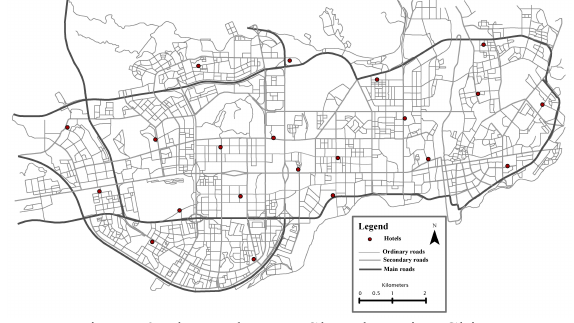
Figure 6. The study area, Shenzhen city, China.